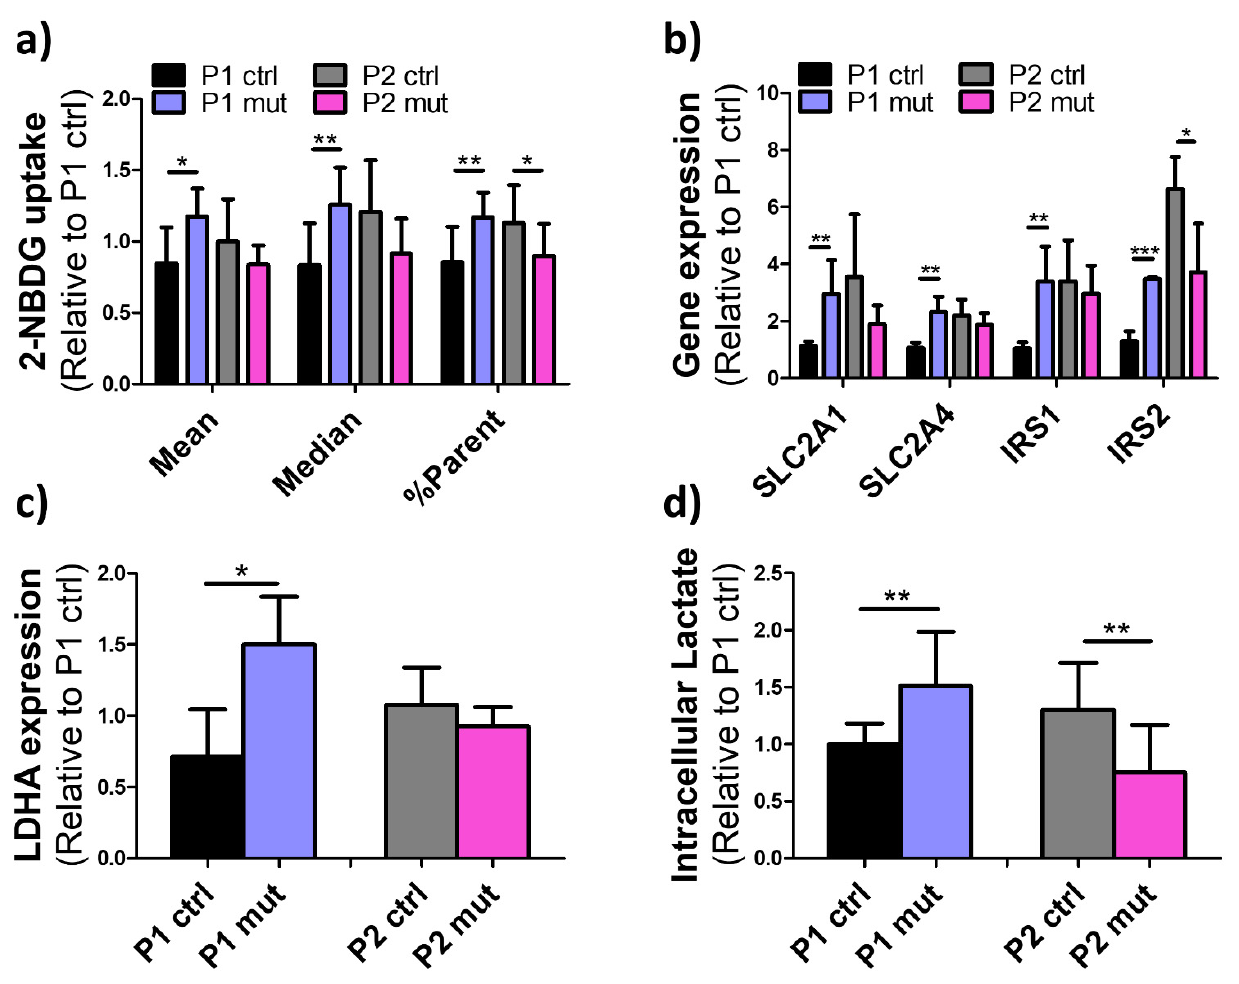
Figure 4. Compensatory glucose metabolism is upregulated in the non-cardiomyopathy patient’s cells. ( a ) Flow cytometry analysis of fluorescent glucose analog (2-NBDG) uptake in iPSC-CMs. Mean and median intensity of 2-NBDG fluorescence intensity and the proportion of 2-NBDG positive cells (%Parent) are shown. Results are relative to one P1 ctrl line. Whereas in P1 a high mutation amount increases cellular glucose uptake, in P2 it decreases it. 3 independent experiments, P1 ctrl n = 8, P1 mut n = 6, P2 ctrl n = 8, P2 mut n = 8. ( b ) Expression of genes regulating glucose uptake. Results are relative to P1 ctrl. Three independent experiments, n = 6. ( c ) LDHA gene expression. Results are relative to one P1 ctrl line. Three independent experiments, n = 6. ( d ) Intracellular lactate levels measured with Lactate assay kit. Results are relative to one P1 ctrl line. 2 independent experiments, P1 ctrl n = 9, P1 mut n = 14, P2 ctrl n = 10, P2 mut n = 10. Fitting with the glucose usage, a high mutation amount increases lactate levels in P1 cells but decreases them in P2 cells. * p < 0.05 ** p < 0.01 *** p < 0.00. All results are shown as mean +/ −